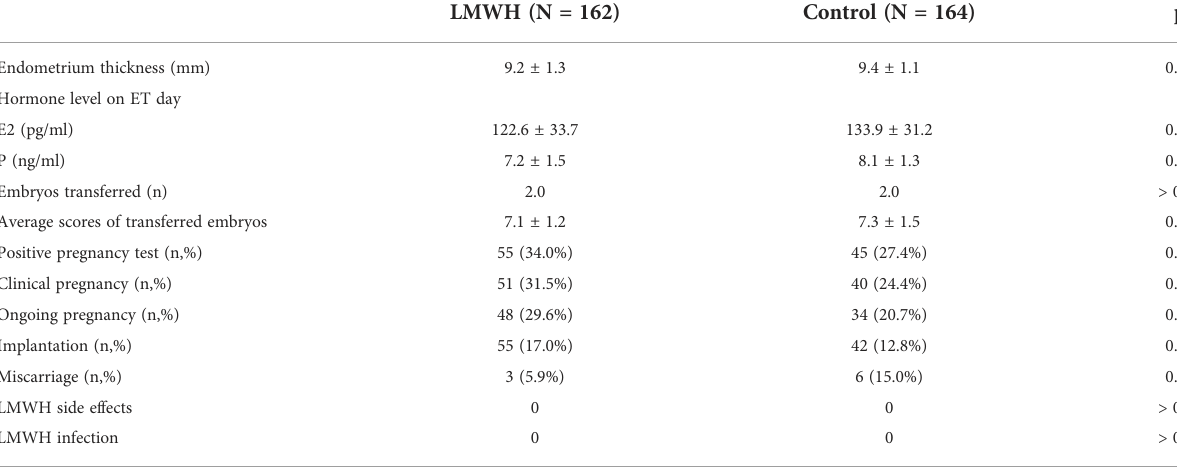
TABLE 2 Summary of treatment and pregnancy outcomes of LMWH and control